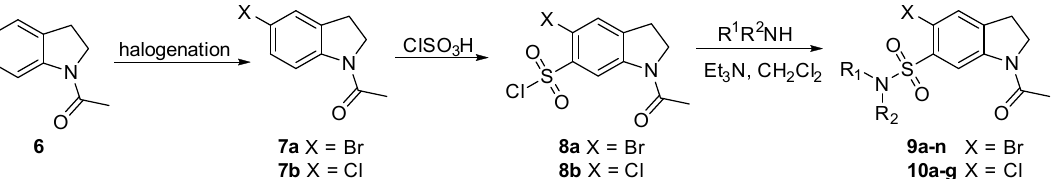
Figure 3. Docked N-isoamyl indoline sulfonamide hit compound 4 (cyan). The majority of the active site residues were contributed to by subunit I of the DapE dimer (green residues), but two residues came from subunit II of the dimer (orange).